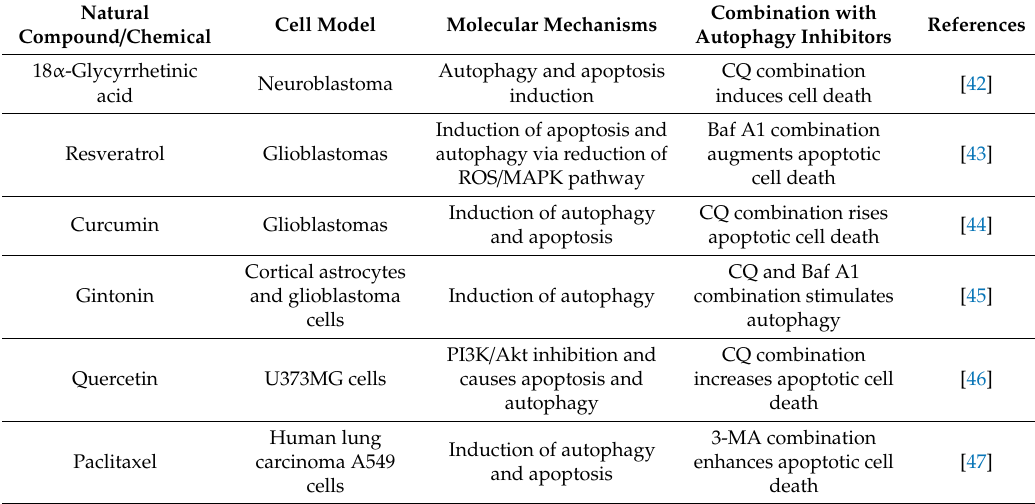
Table 1. Mechanism of action of combination of natural compounds and autophagy blockers, 3-methyladenine (3-MA), chloroquine (CQ), and bafilomycin A1 (Baf A1) in modulating autophagy and apoptosis in various cancer cell